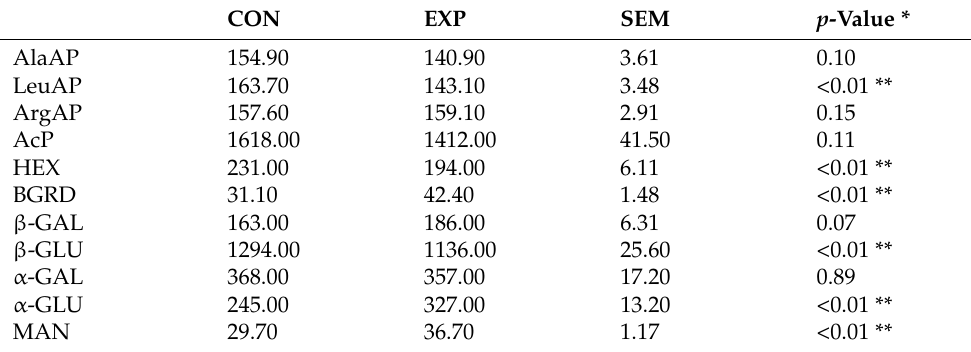
Table 1. The activity (nmol/mg protein/h) of lysosomal enzymes in ruminal fluid in the control and experimental group. CON EXP SEM